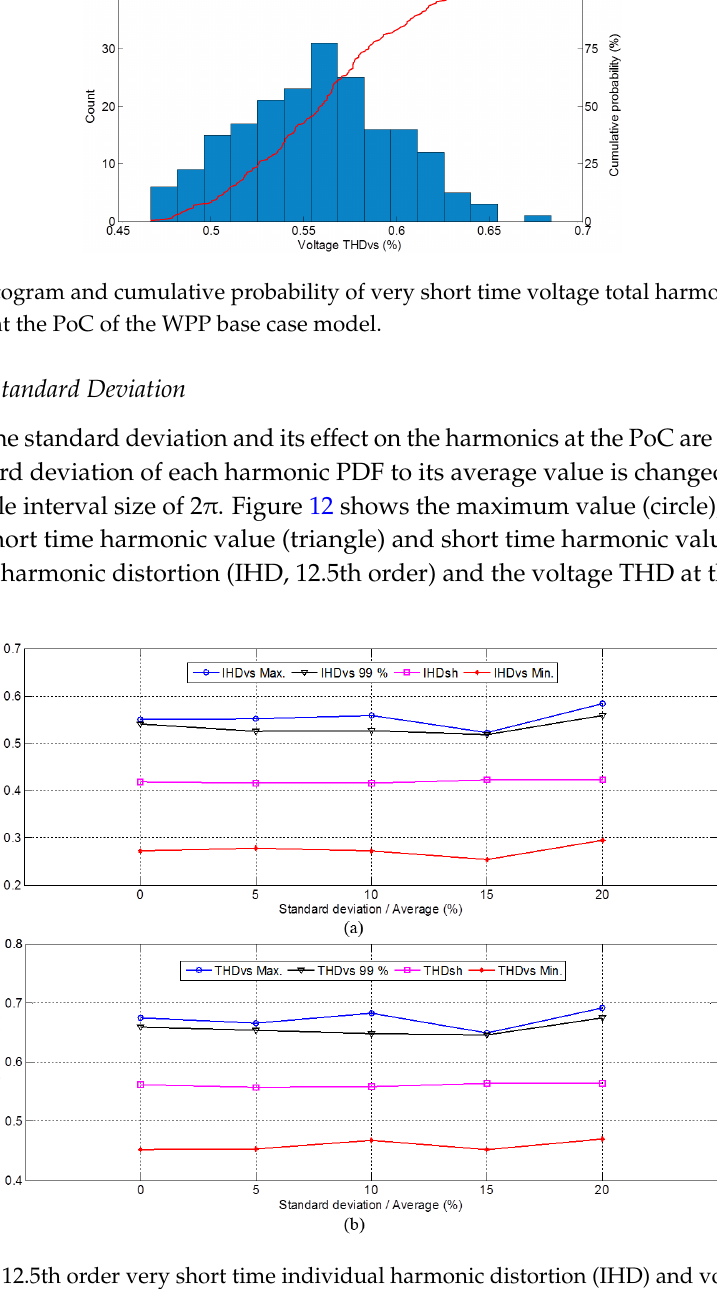
Figure 12. The 12.5th order very short time individual harmonic distortion (IHD) and voltage THD in the variation of the standard variation: ( a ) 12.5th order; and ( b ) voltage